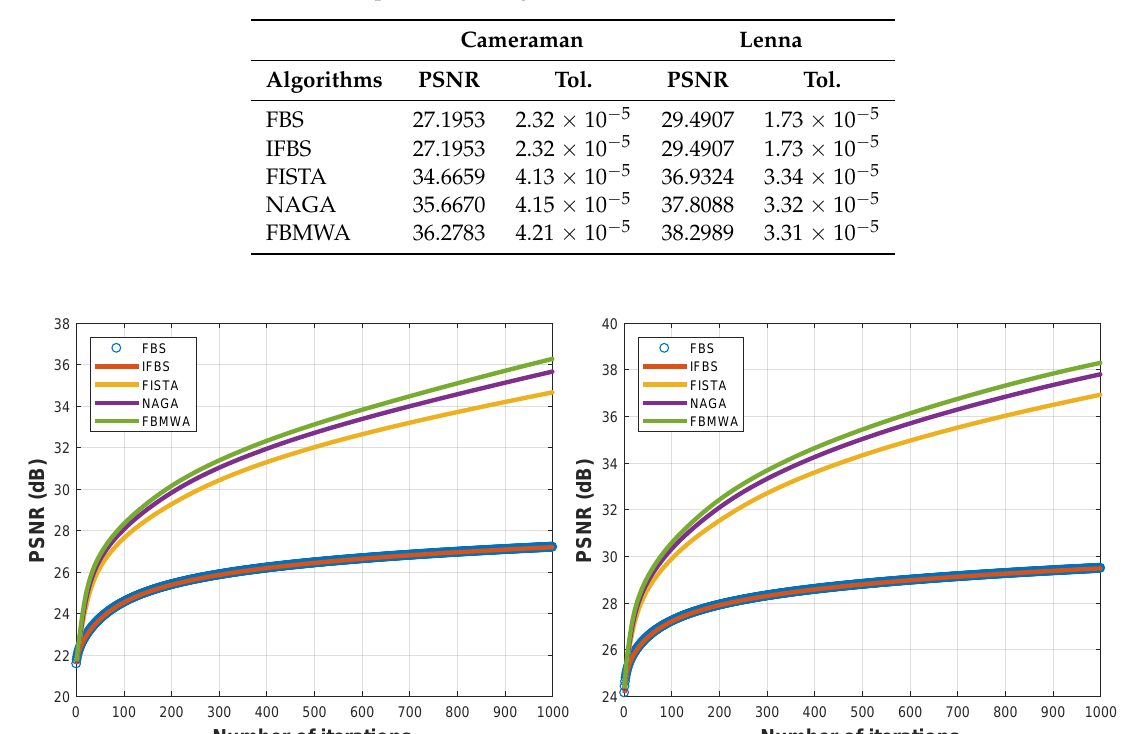
Table 1. Comparison of image restorations of the studied methods.